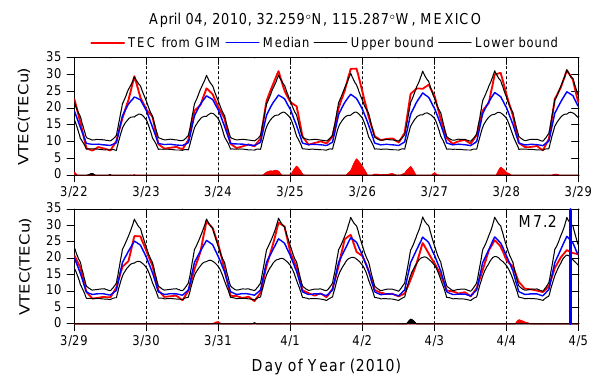
Fig. 6. VTEC time series above the Chile epicenter during Fig. 7. Dst, F 10.7 , and K p indices during 22 March 2010 to 4 April 2010. 14 February 2010 to 27 February 2010. Symbols in this figure are the same as those in Fig. 3.